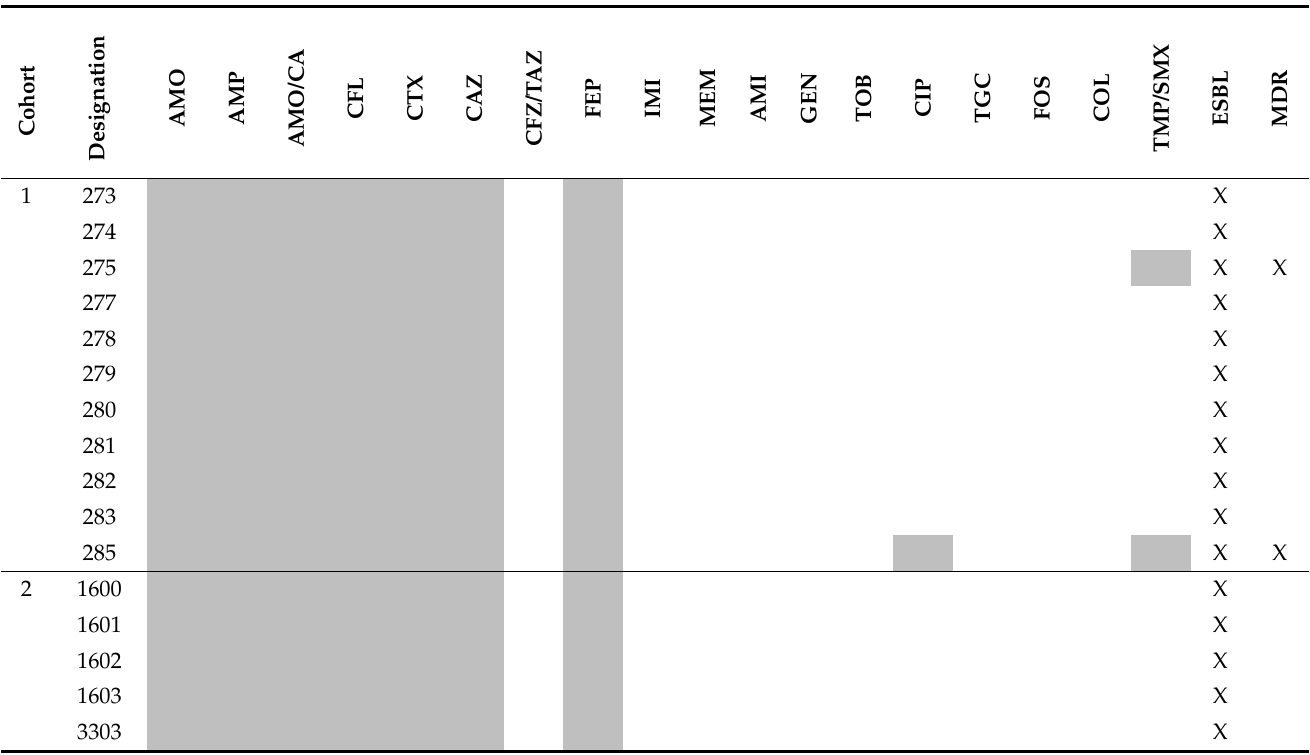
Table 2. Phenotypic resistance profiles of extended-spectrum beta-lactamase (ESBL)- E. coli isolates obtained from cloacal samples of semi-wild mallard ducks and pooled fecal